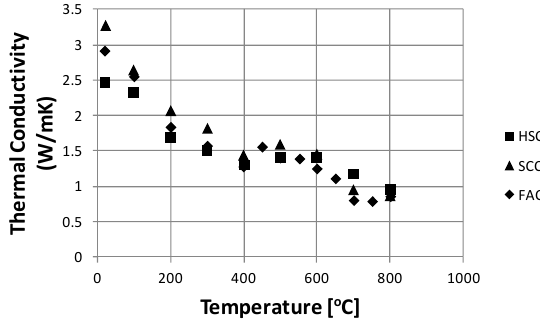
Figure 3. Temperature dependent thermal conductivity for high strength concrete (HSC), self compacting concrete (SCC) and fly ash concrete (FAC) with w/c ratios of 0.25 ‐ 0.28